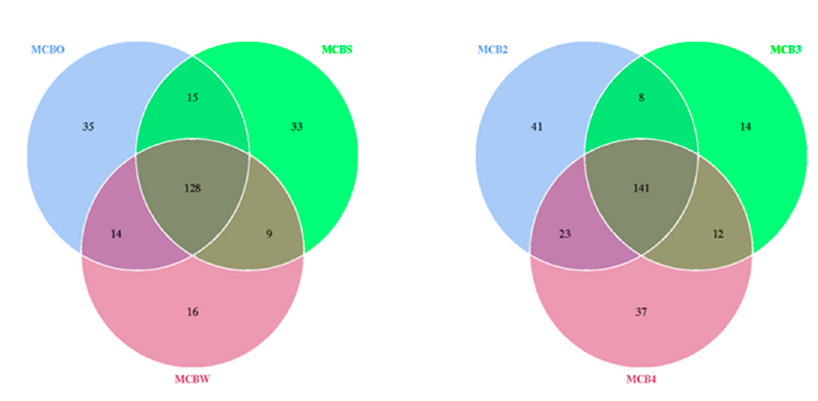
Figure 5. Venn diagram showing the degree of overlap of bacterial operational taxonomic units (OTUs) between the swab samples obtained from the purchased cutting board (MCBO), the scraped cutting board (MCBS) and the rinsed cutting board (MCBW). MCB2, MCB3 and MCB4 represent sampling after the second, third and fourth experimental repetitions, respectively. The numbers of shared and unique OTUs between bacterial species are shown.